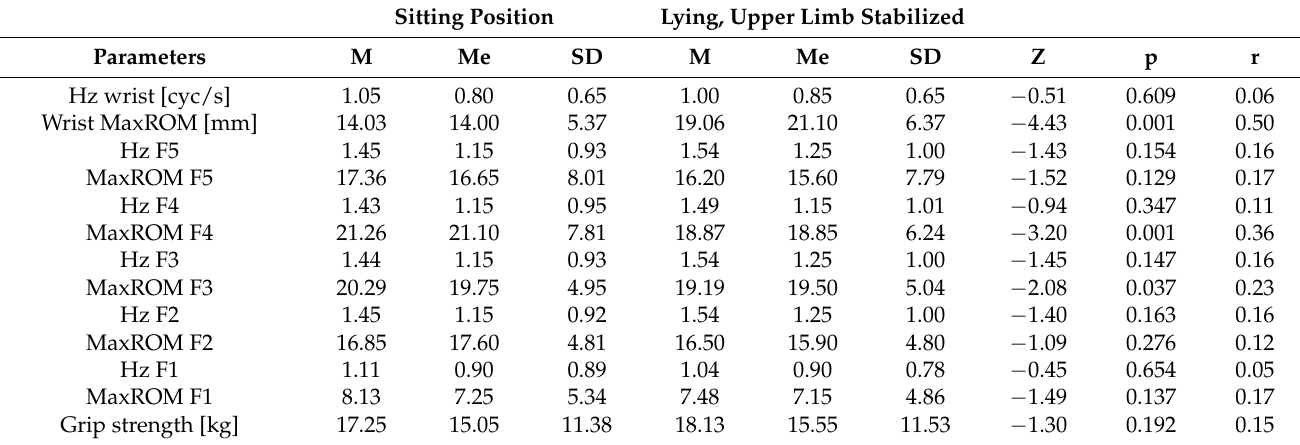
Table 5. Comparison of movement and strength parameters in sitting and lying positions with upper limb against the body in patients after ischemic stroke. Sitting Position Lying, Upper Limb Stabilized